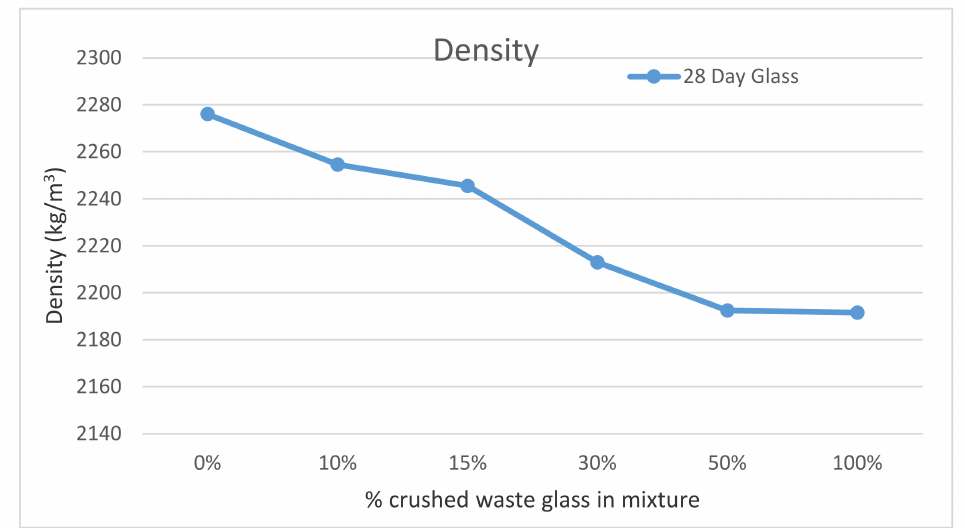
Figure 10. Effect of the proportion of glass sands on the 28-day hard density of concrete.